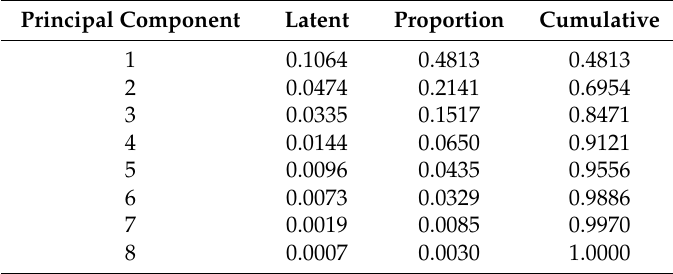
Table 2. Latent, proportion, and cumulative values of selected principal components for relative voltage value feature in the IAQ dataset.